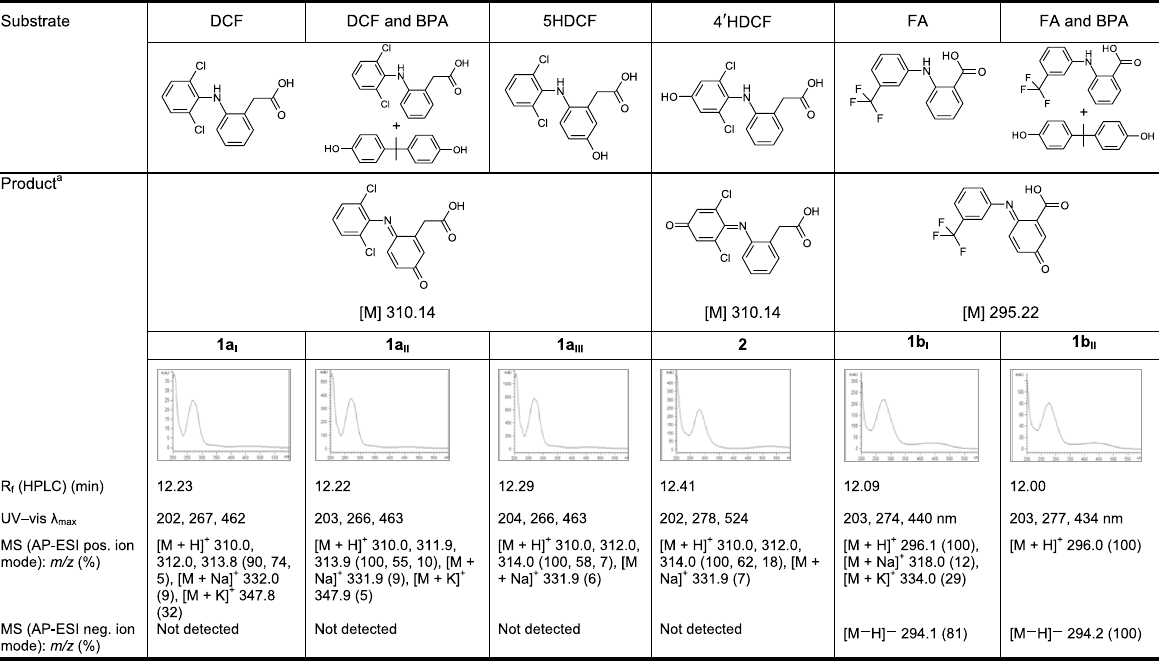
Table 1 Structural data of products 1a formed during laccase-mediated reactions of DCF alone or in I–III